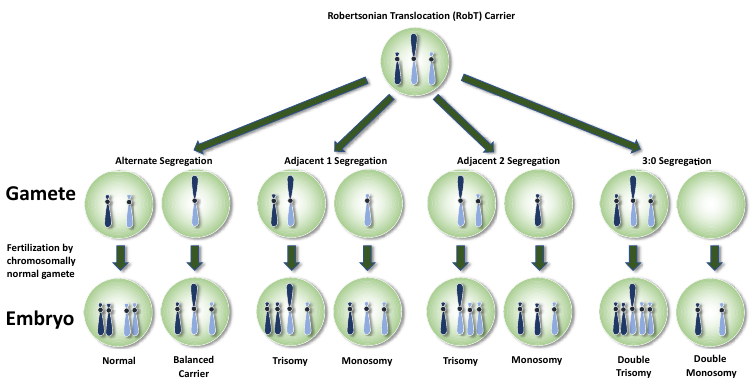
Figure 1. Segregation patterns of a Robertsonian translocation (RobT) in the gametes and in the resulting embryos following fertilization with a normal gamete.